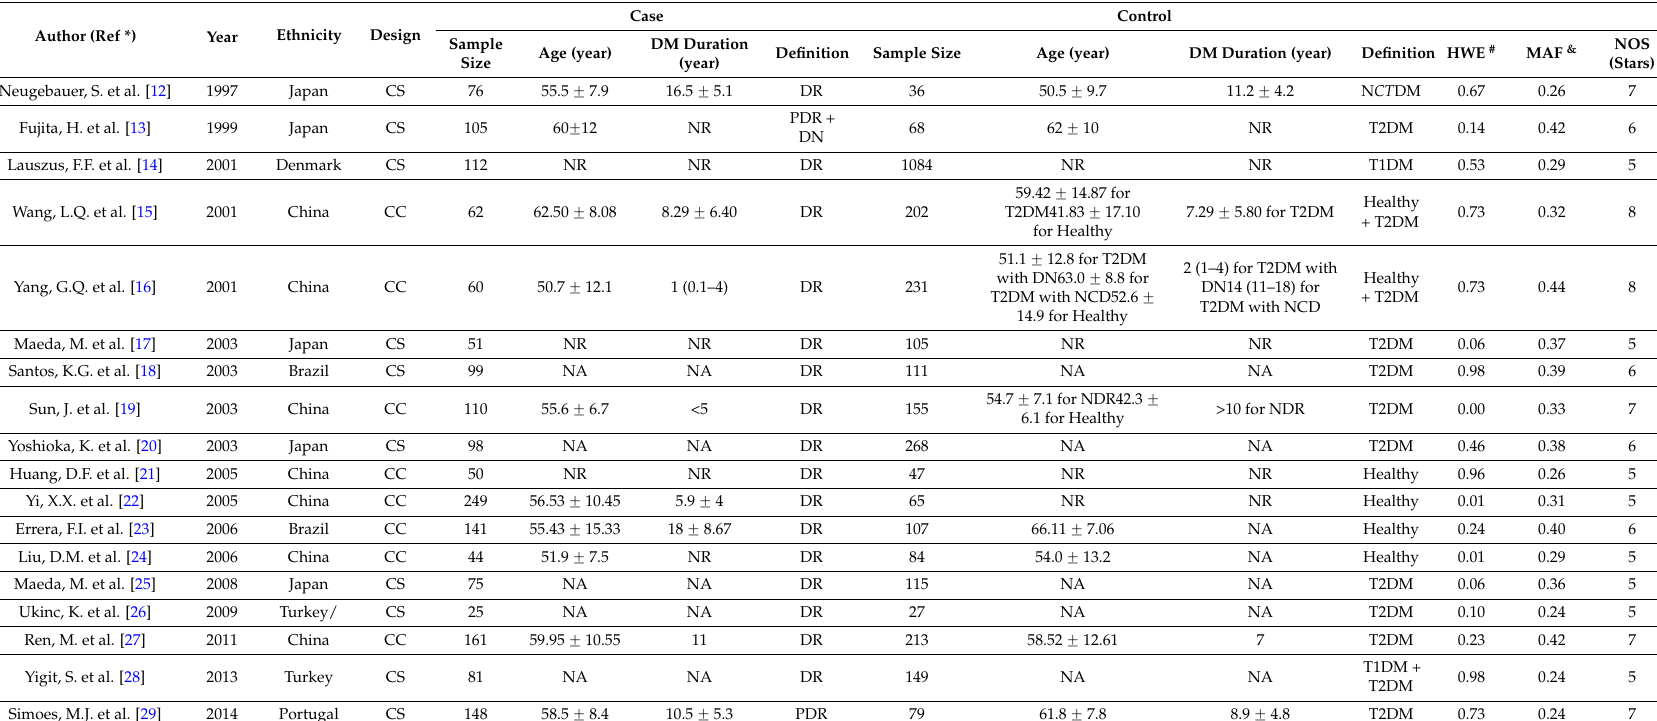
Table 1. Baseline characteristics of qualified studies included in the